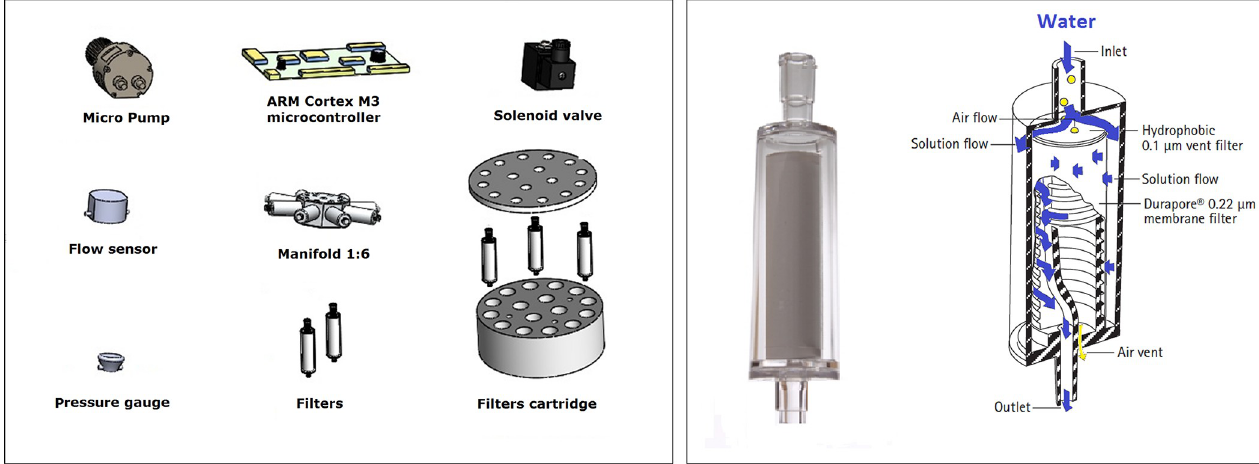
Fig 1. Electronic, micro-hydraulic and filters components. A) System components such as the pump, microcontroller, solenoid valve, flow sensor, manifold, pressure gauge, filters and filters cartridge used in the development of the IS-ABS. B) Sterivex-GP filter image (left) and Sterivex-GP filter diagram and water flow (right) during filtration procedure (adapted from User Guide